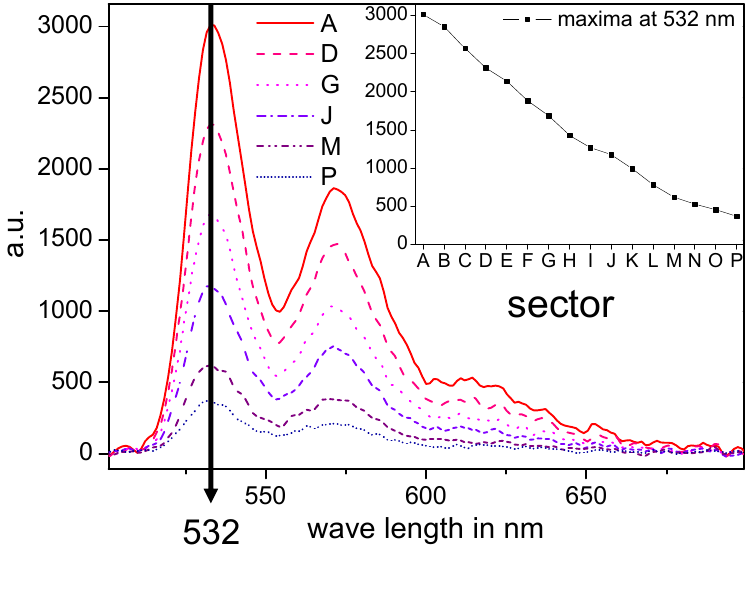
Figure 2. The characterization of the fluorescent dye gradient in PMMA via fluorescence spectroscopy: 16 fluorescence spectra (sector A–P) along the application direction with an equal gap were measured (only six spectra are shown over the full measured wave length range for a better overview). The inset of the graph shows the intensities of the maximum at 532 nm of the spectra of all 16 sectors and verifies distinctly the continuous decrease of the fluorescence intensity given by the material